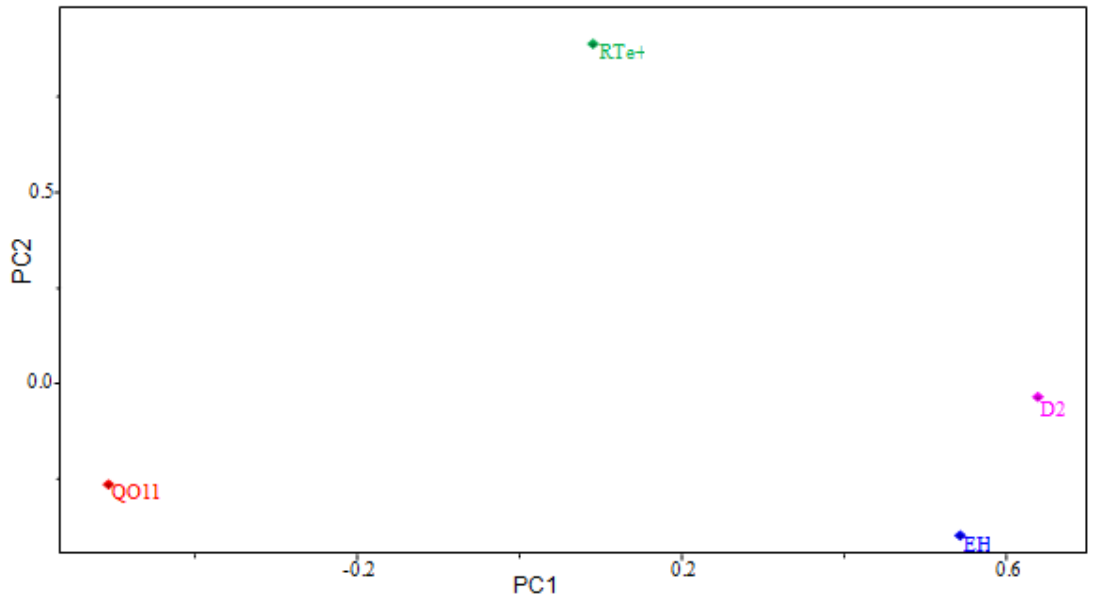
Figure 5. Plot of the PC1–PC2 loadings with the four descriptors selected to build the PLS and PCR models of artemisinin and derivatives with biological activity against W-2 strains of P. falciparum